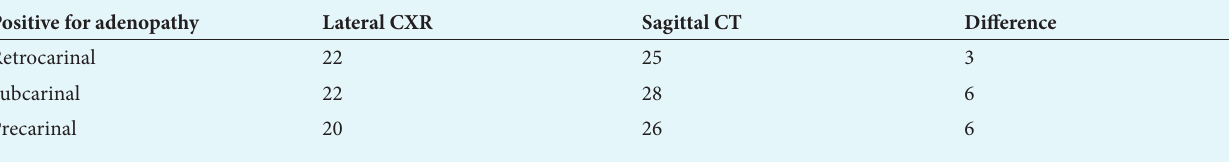
Table 1. Positive findings of lymphadenopathy on lateral CXR and sagittal CT reconstruction according to zone in 30 children with PTB